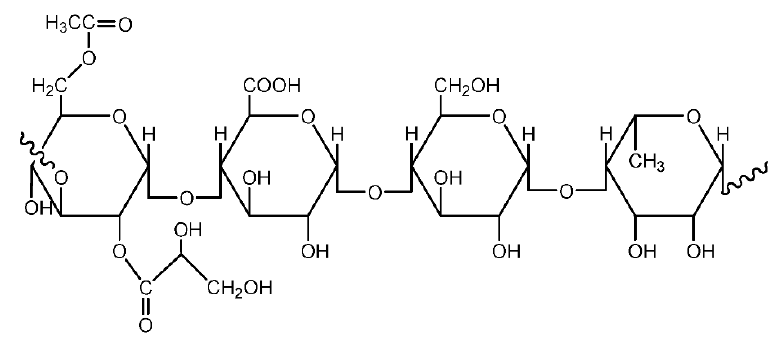
Figure 15. Representative unit of Gellan Gum.